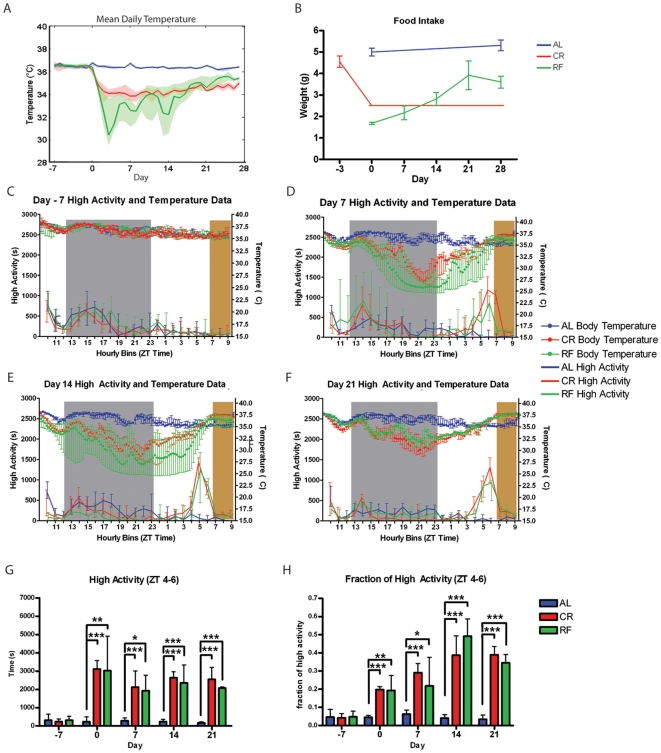
Comparison of behavior and body temperature under temporally and calorically restricted feeding conditions.(A) Mean daily temperature for each group of mice during the experiment. The bold line represents the median of the mean daily temperatures for individual mice, and the shaded regions represent the IQR. (B) Food intake for each group of mice. The line represents the mean and the bars represent the SEM. (C) Temperature and high activity seconds per hr seven days prior to beginning the special feeding regimen. Median temperature is represented by the filled circles in the top half of the panel (corresponding to the right y-axis) and median high activity is represented by the solid line in the bottom half of the panel (corresponding to the left y-axis). The bars represent IQR. (D) Temperature and high activity seconds per hourly bin seven days after the start of the special feeding regimen. (E) Temperature and high activity seconds per hourly bin 14 days after the start of the special feeding regimen. (F) Temperature and high activity seconds per hourly bin 21 days after the start of the special feeding regimen. (G) Seconds of high activity observed during the three hours prior to feeding (ZT 4–6) for the duration of the experiment. Medians and IQR are shown. (H) Seconds of high activity observed during the 3 hrs prior to feeding (ZT 4–6) divided by total seconds of high activity during the entire recording period. *  =  p<0.05, **  =  p<0.05, ***  =  p<0.001 (Kruskal-Wallis Test with Dunn's Post Test). n = 9 for AL, n = 8 for CR, and n = 6 for RF.